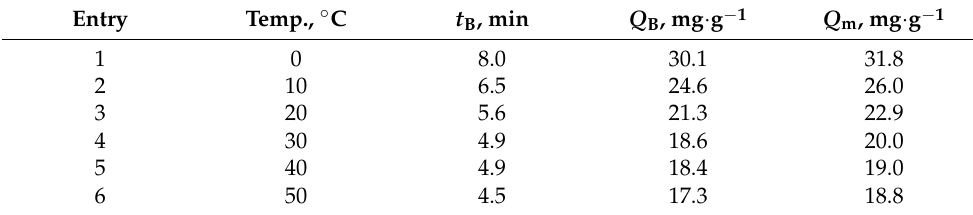
Table 3. Adsorption properties of rGOA-200 at different